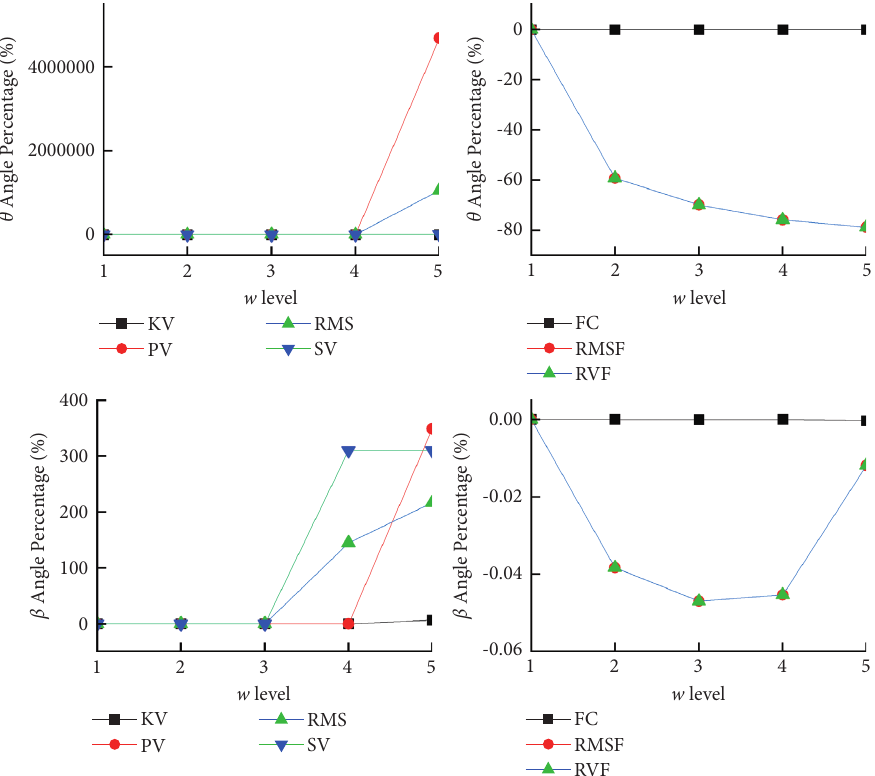
Figure 9: Effect of the luffing acceleration on the lift-luffing angles.